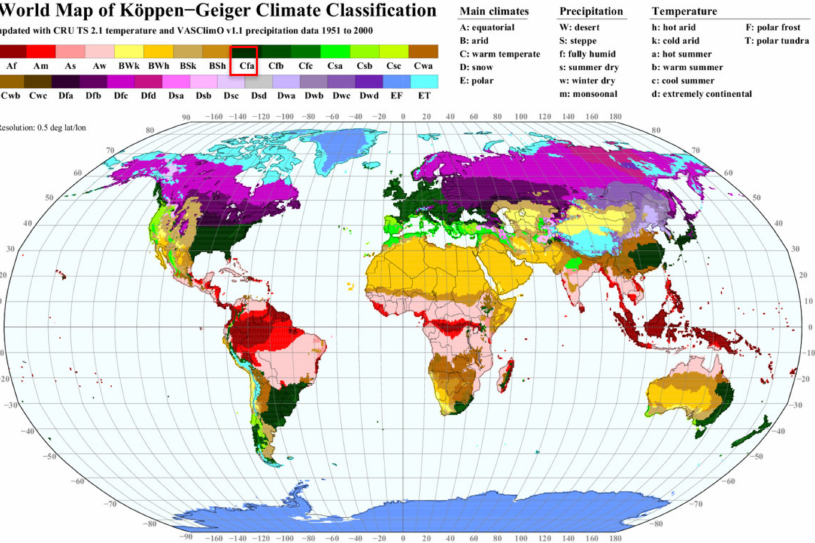
Figure 9. Köppen–Geiger world climate classification map for the period 1951 to 2000 on a 0.5-degree regular grid (in both latitude and longitude). Updated mean monthly temperature and precipitation data (CRU TS 2.1 and VASClimO v1.1, respectively) (adapted from